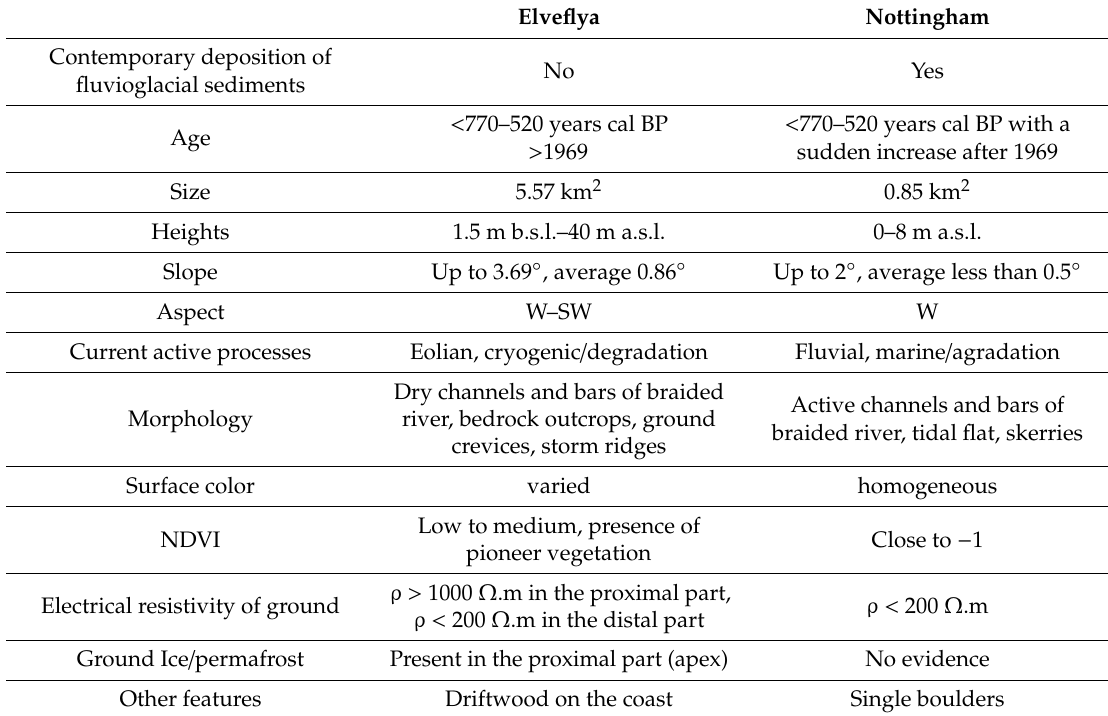
Table 5. Main features of Elveflya and Nottingham outwash